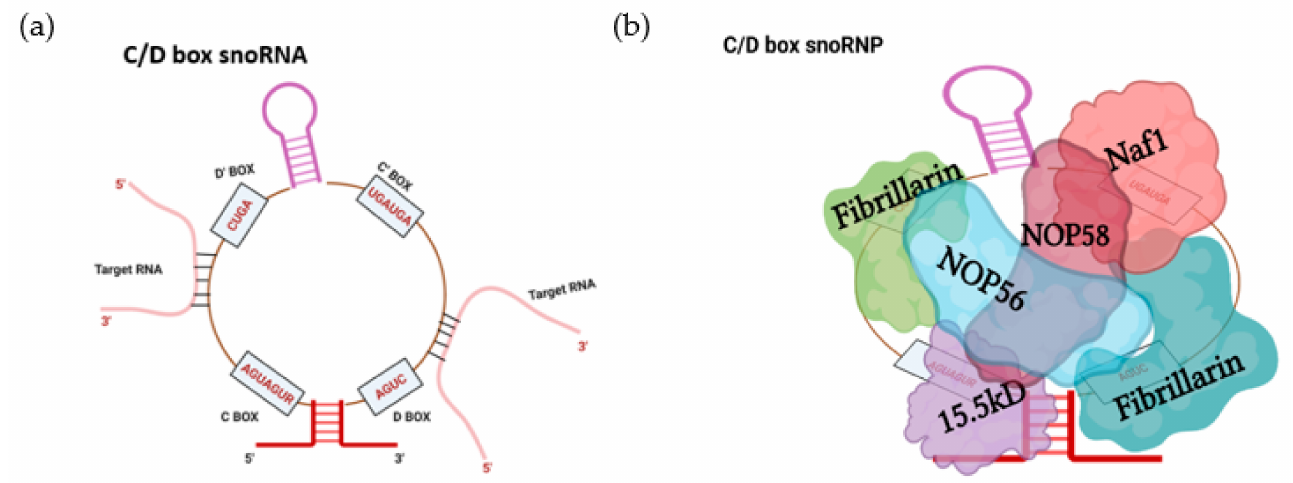
Figure 1. The C/D box snoRNA structural features and associated protein cohort: ( a ) Stem-bulge-stem (K-turn) structure is a characteristic feature of the C/D box snoRNAs. At the 5 (cid:48) and 3 (cid:48) termini lie the Box C (RUGAUGA) and Box D (CUGA) conserved sequences whilst the boxes C (cid:48) and D (cid:48) represent internal less-conserved sequence elements. The guide sequences (antisense elements) upstream of the box D/D (cid:48) are complementary to target RNAs and form the sequence recognition component. ( b ) Fibrillarin (green), Nop58 (violet), Nop56 (Blue), and 15.8kD (Purple) proteins associate with C/D box snoRNAs to form a functional snoRNP. Fibrillarin enzymatically facilitates 2 (cid:48) -O-ribose-methylation of target RNAs while the other three proteins facilitate the localization, maturation, and stability of C/D box snoRNAs.